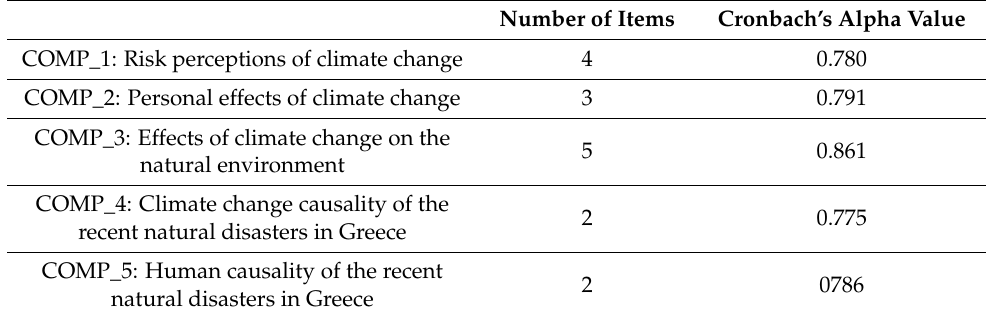
Table 2. Extracted components’ Cronbach’s alpha values.